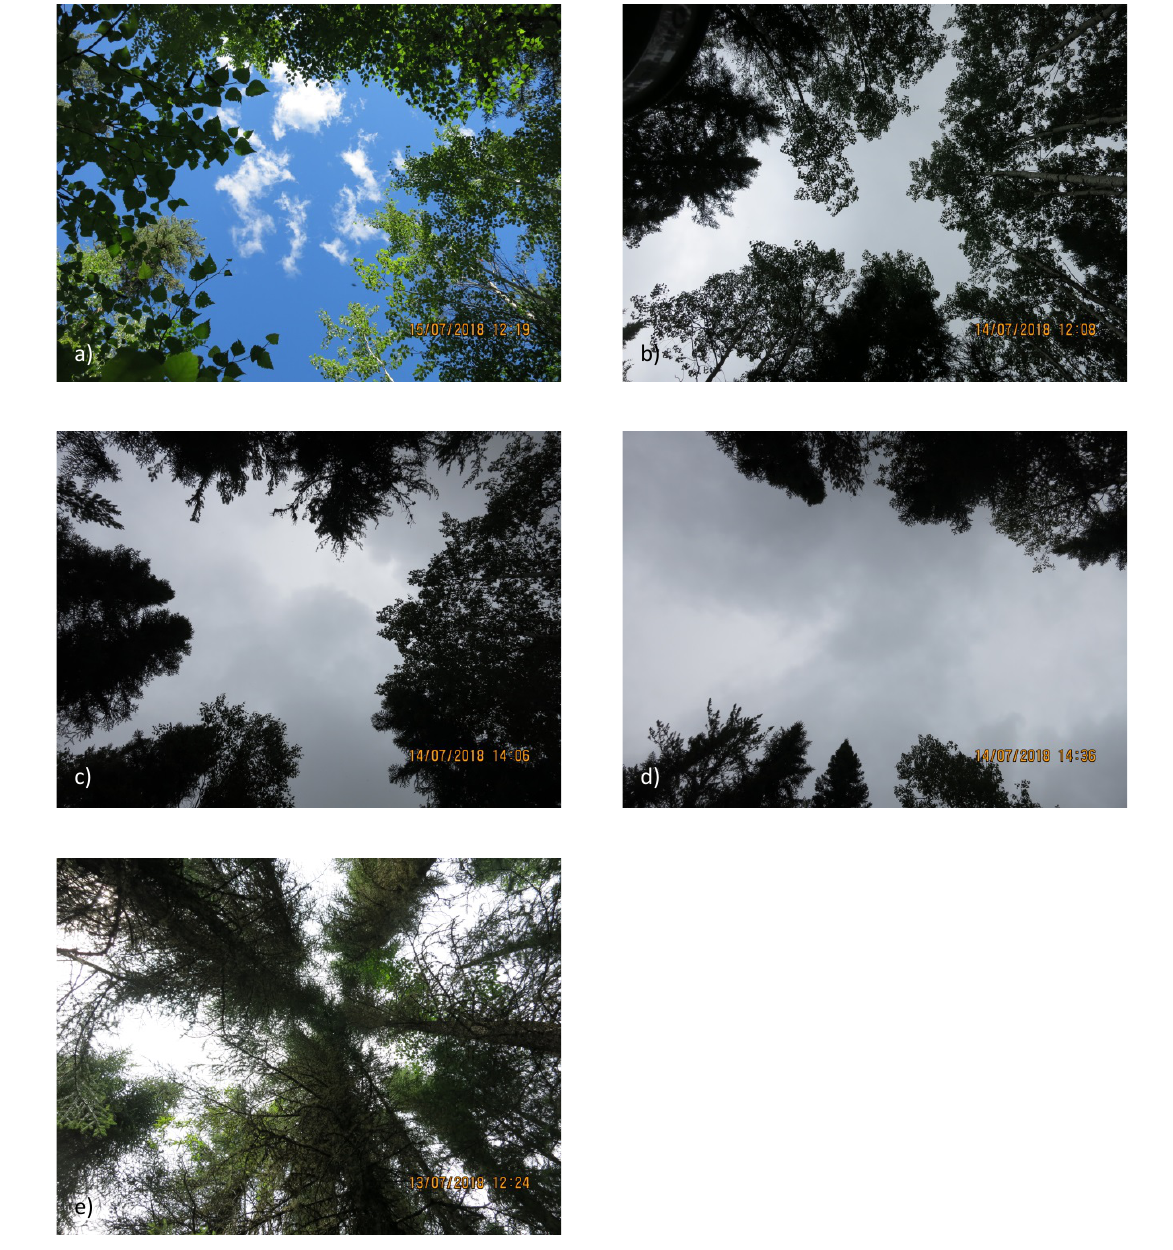
Figure 3. Vertical photography displaying representative samples of openings from classes 1 ( a ), 2, ( b ), 3 ( c ), and 4 ( d ), as well as no-opening class 0 ( e ).